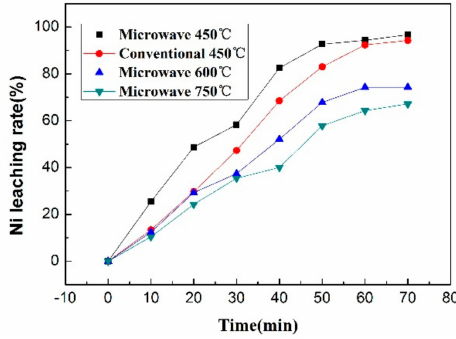
Figure 10. E ff ect of pretreatment temperature on nickel leaching